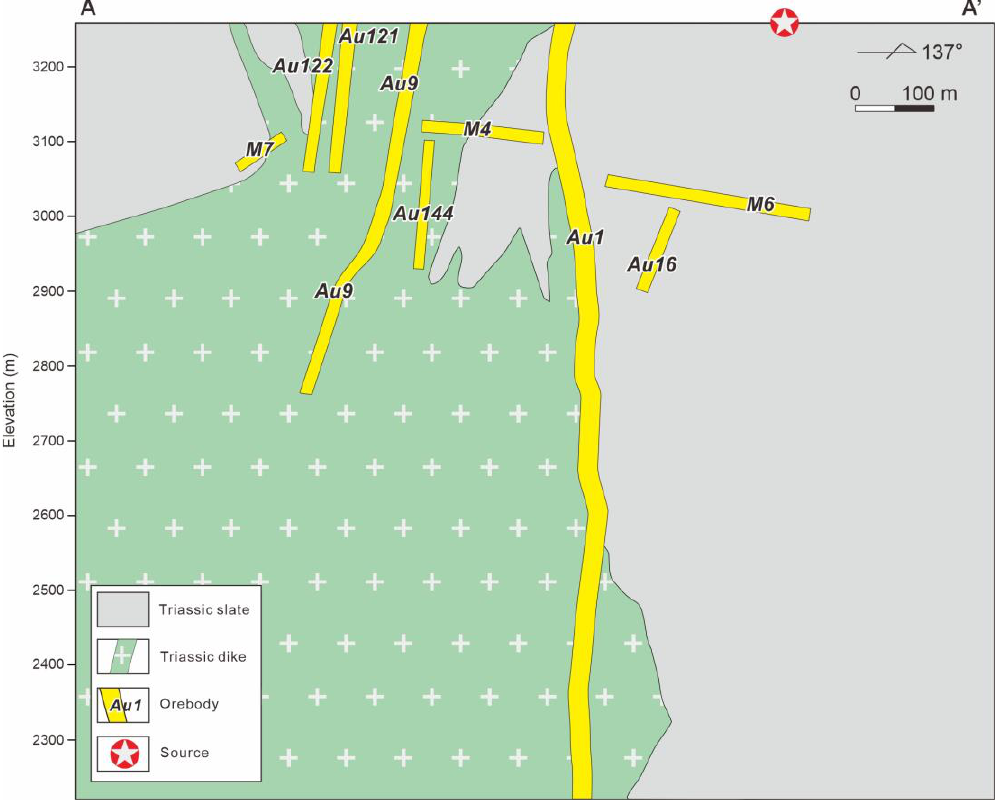
Figure 7. Schematic profile A- A′ in Figure 6 at the Zaozigou deposit (modified after [65,66]).